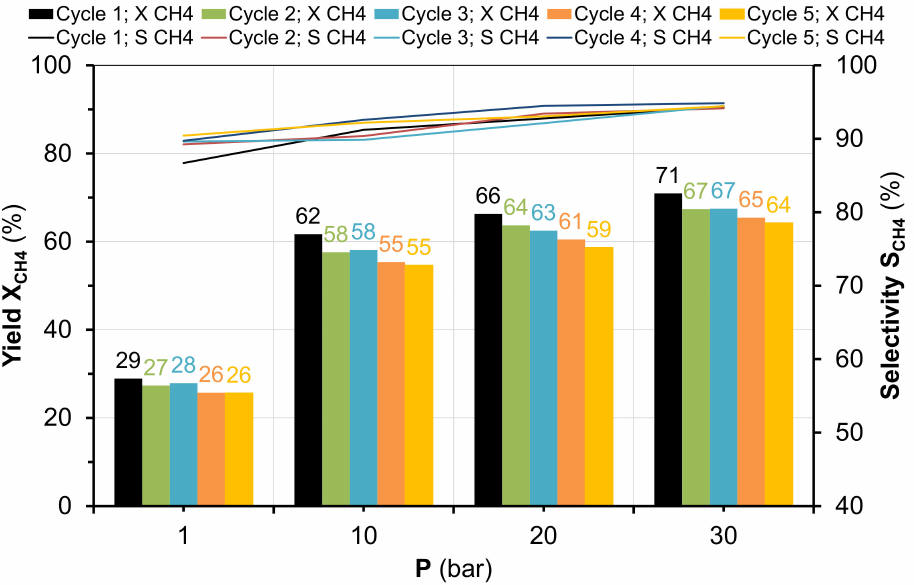
Figure 5. Recycle study performed over the nickel–cerium bimetallic oxide catalyst at 300 ◦ C pre- treatment under hydrogen: cycle 1 black; cycle 2 green; cycle 3 blue; cycle 4